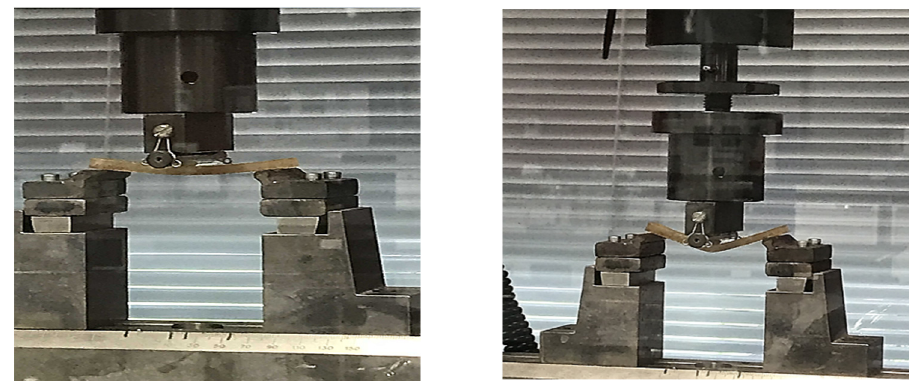
Figure 11. The flexural testing of SFRE samples.